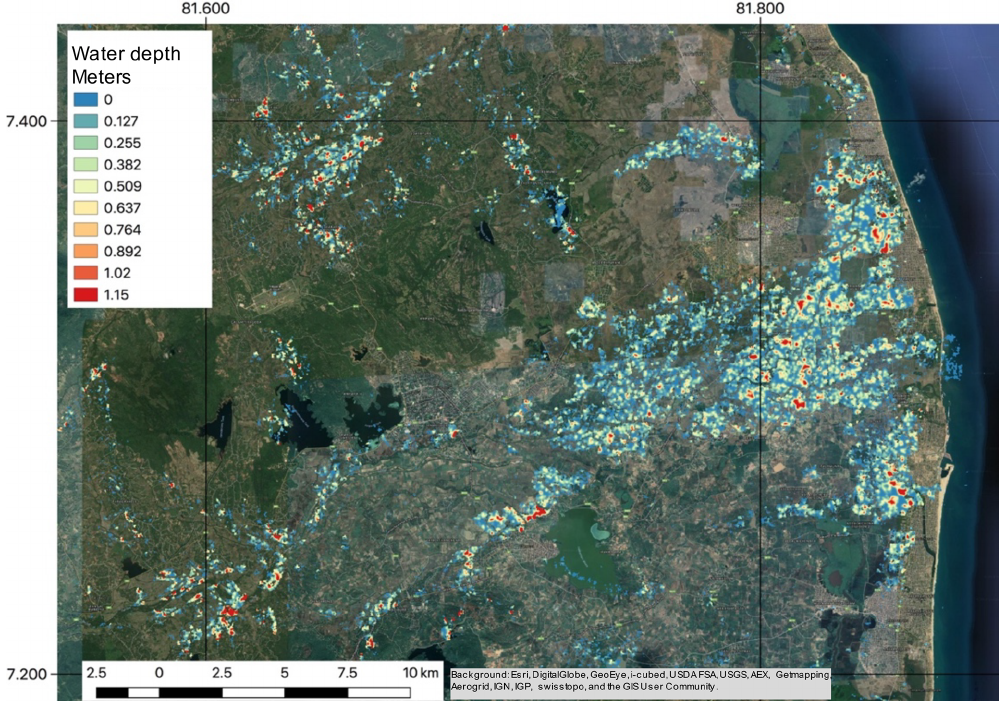
Figure 6. A floodwater depth map shared during the GFP activation for the 2018 flooding in Sri Lanka, zooming in on the southeast part of the country. Water depth was calculated using FwDET v2.0 with a 10m flood inundation map (for 19 May 2018) and 30m DEM (ALOS). Background sources: Esri, DigitalGlobe, GeoEye, i-cubed, USDA FSA, USGS, AEX, Getmapping, Aerogrid, IGN, IGP, swisstopo, and the GIS user